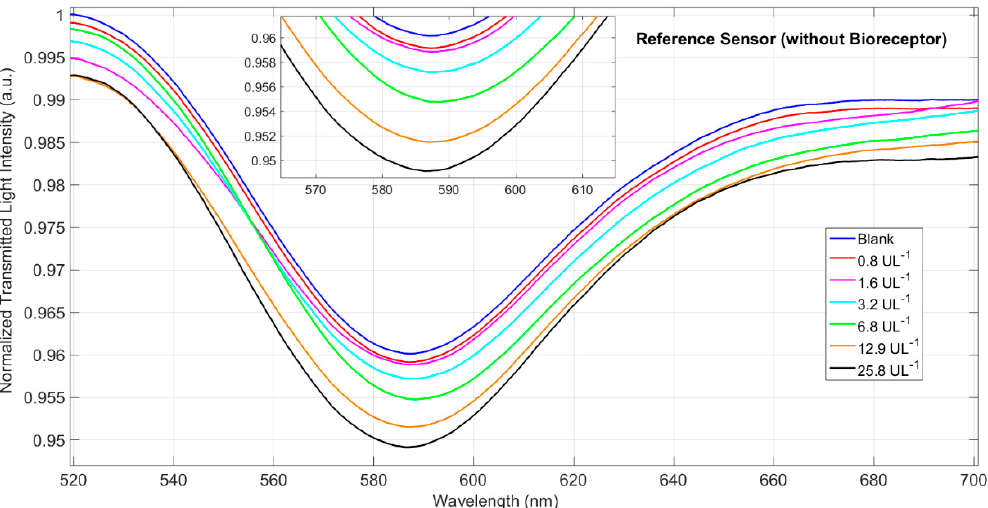
Figure 8. Transmission spectra of SPR-POF platform non-functionalized and tested with PO fluid solution.